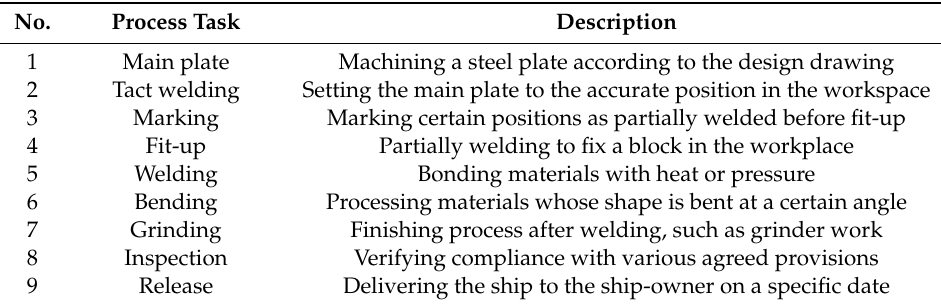
Table 2. Production process detailed descriptions for large assembly blocks.